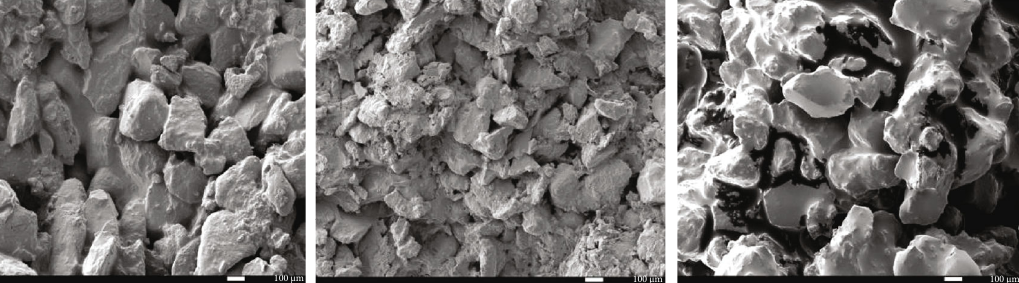
Figure 4: SEM images of oil sand.